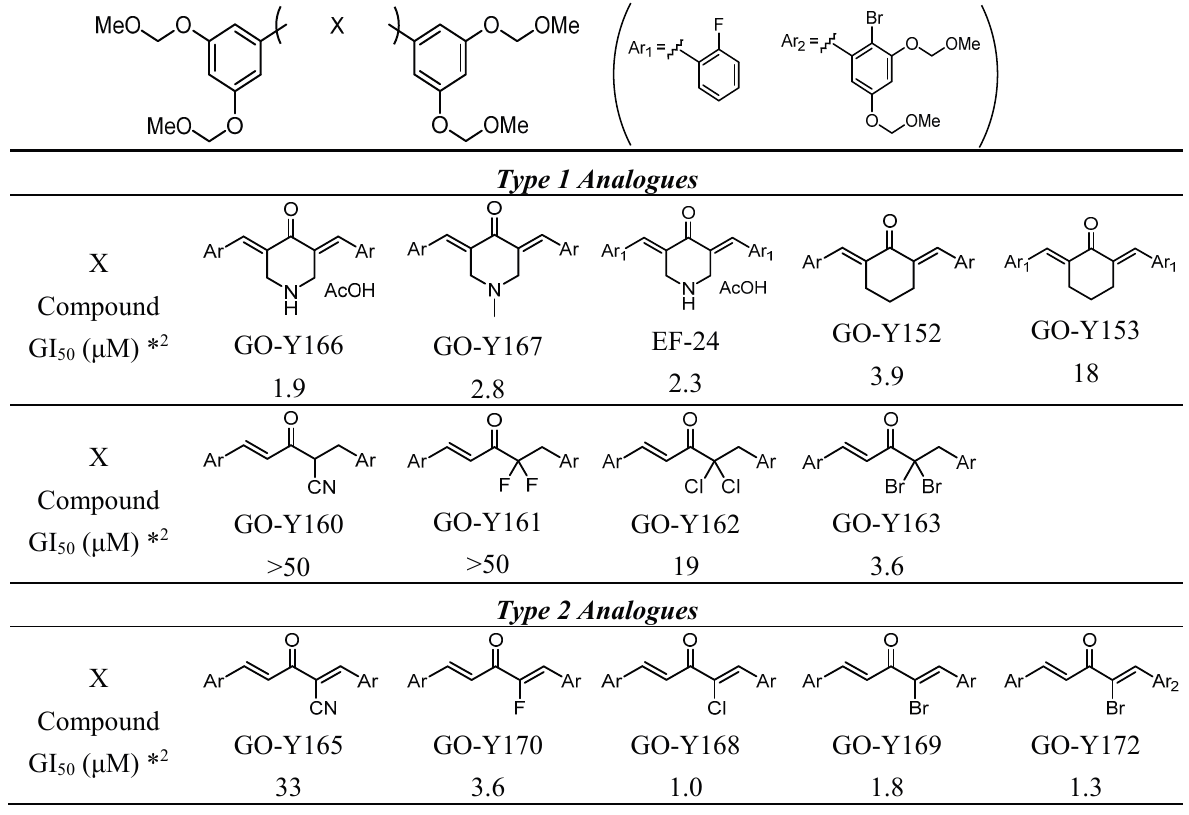
* 2 Cell growth inhibition against